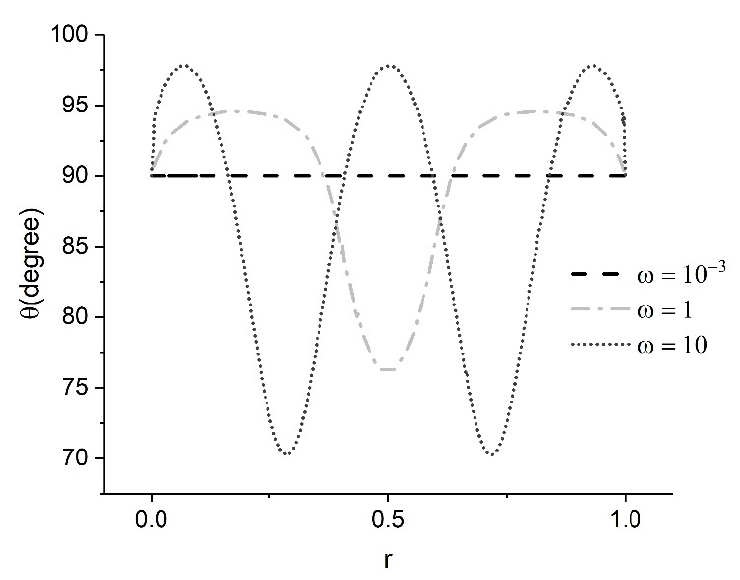
Figure 8. Unstable solution branch for 20 mg/mL GO at different shear rates showing the increase in non-dimensionless shear rate results in oscillations within the orientation using the EL theory.